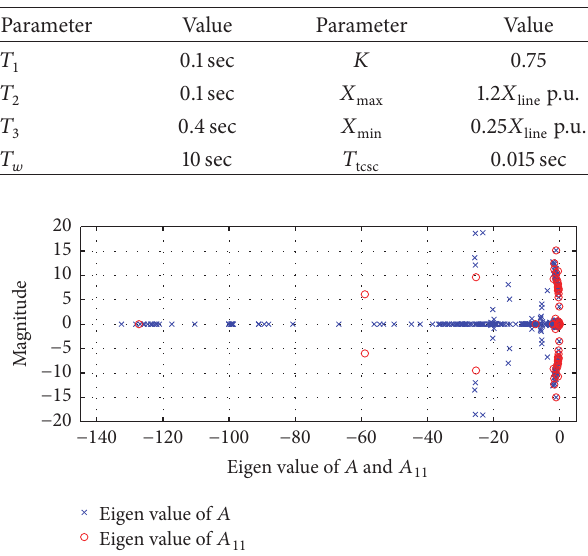
Figure 6: Eigenvalue distribution before and after using balanced